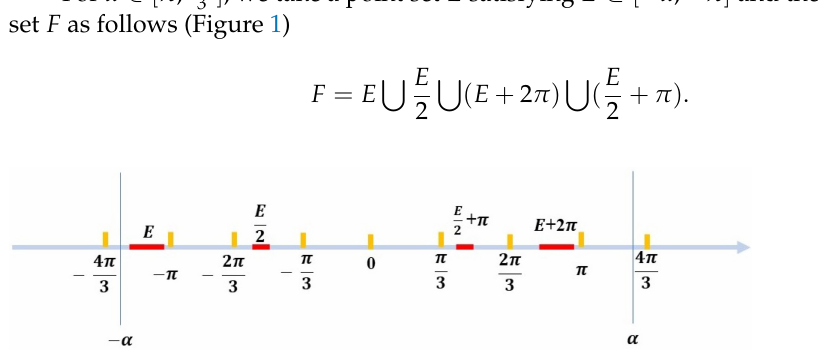
Figure 1. The point set F